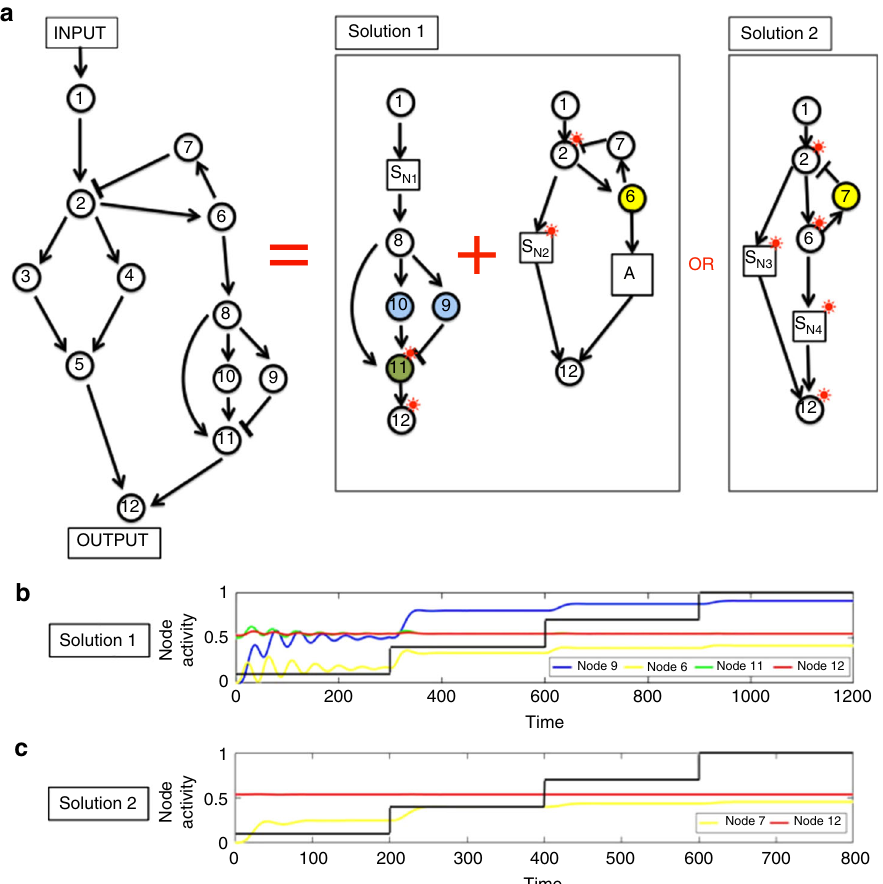
Fig. 7 A single arrangement of nodes with multiple RPA solutions. Here we feature a network topology that is capable of exhibiting RPA through two different decompositions into RPA Basis Modules. a In Solution 1, the network is able to exhibit RPA as the series interconnection of an Opposer Module (upstream) with a Balancer Module (downstream). The upstream Opposer Module is created when Node 6 (indicated in yellow) exhibits opposer kinetics. Node 6 also participates in a route of the network, corresponding to a live outgoing regulation from the module at this node. This live regulation is then balanced by the downstream Balancer Module when Nodes 9 and 10 (indicated in blue) operate with balancer kinetics, and Node 11 (in green) operates with connector kinetics. Node 2 and its downstream dependents (Nodes 3, 4, and 5, indicated by S N2 in the Solution 1 decomposition) all exhibit the RPA property due to the activity of the upstream Opposer Module. Node 11 exhibits the RPA property due to the activity of the downstream Balancer Module. Node 12 (the output node of the network) exhibits the RPA property due to the combined activities of the two RPA basis modules. In Solution 2, a single Opposer Module is created for the entire network when Node 7 (indicated in yellow) exhibits opposer kinetics. All nodes in the network (with the exception of Node 7 and Node 1) exhibit the RPA property due to the activity of this single RPA basis module. b Numerical simulations for a simple model of Solution 1. Model equations and parameters are given in Supplementary Note 5. The input to the network is indicated in black. c Numerical simulations for a simple model of Solution 2. Model equations and parameters are given in Supplementary Note 5. The input to the network is given in